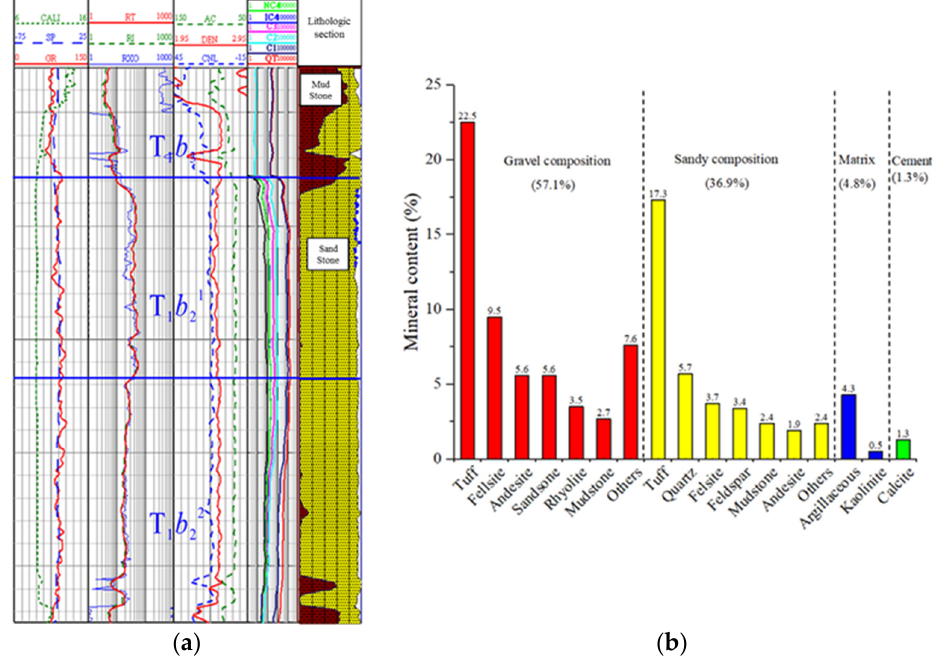
Figure 1. ( a ) Type log for the Triassic Baikouquan formation of Mahu 131 block; ( b ) mineral composi- tion statistics.